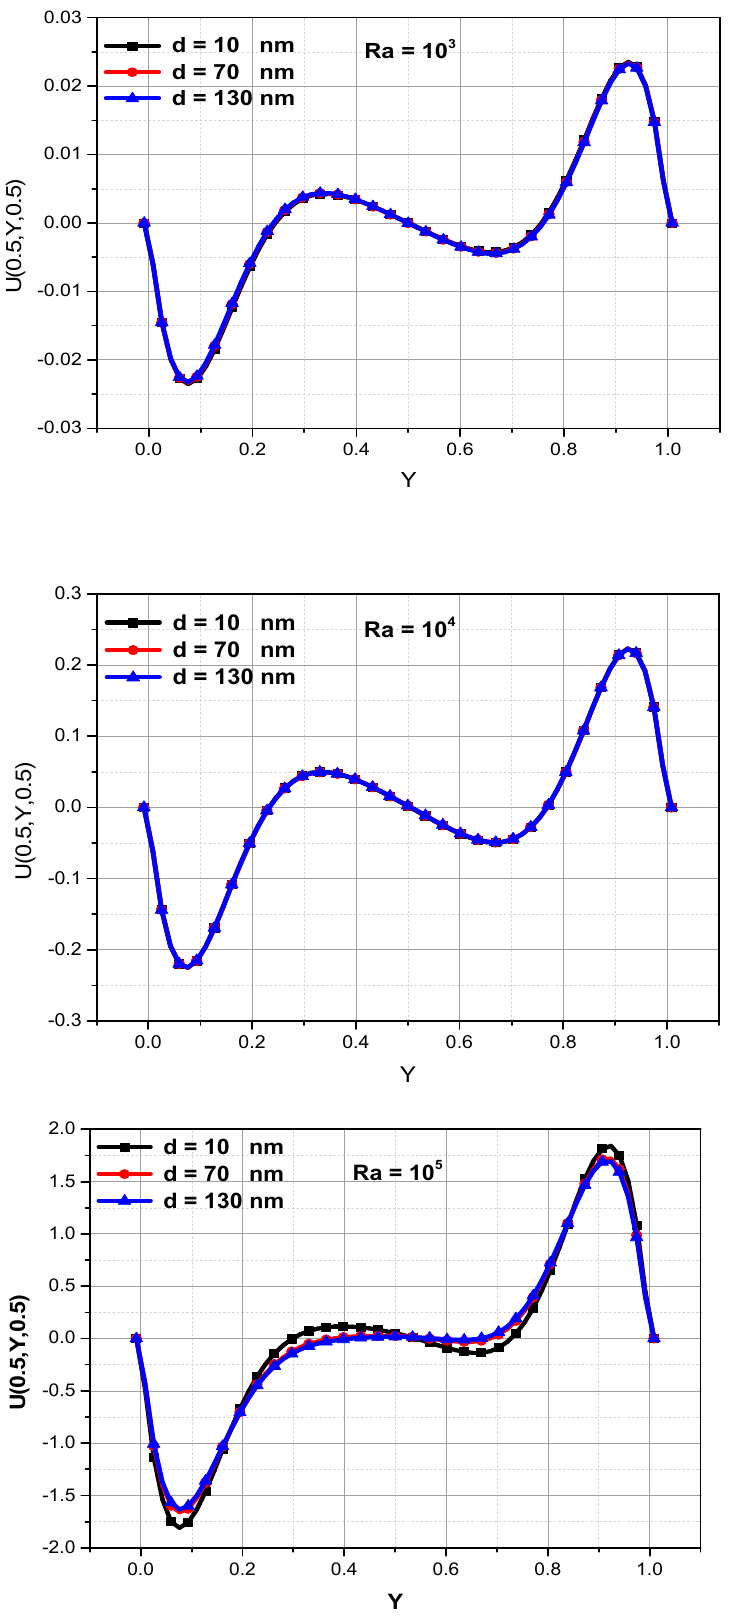
Figure 12. Variation of the velocity profiles on the Y-axis for different Rayleigh numbers and nanoparticle diameters at (Ha = 30 and φ = 0.04).